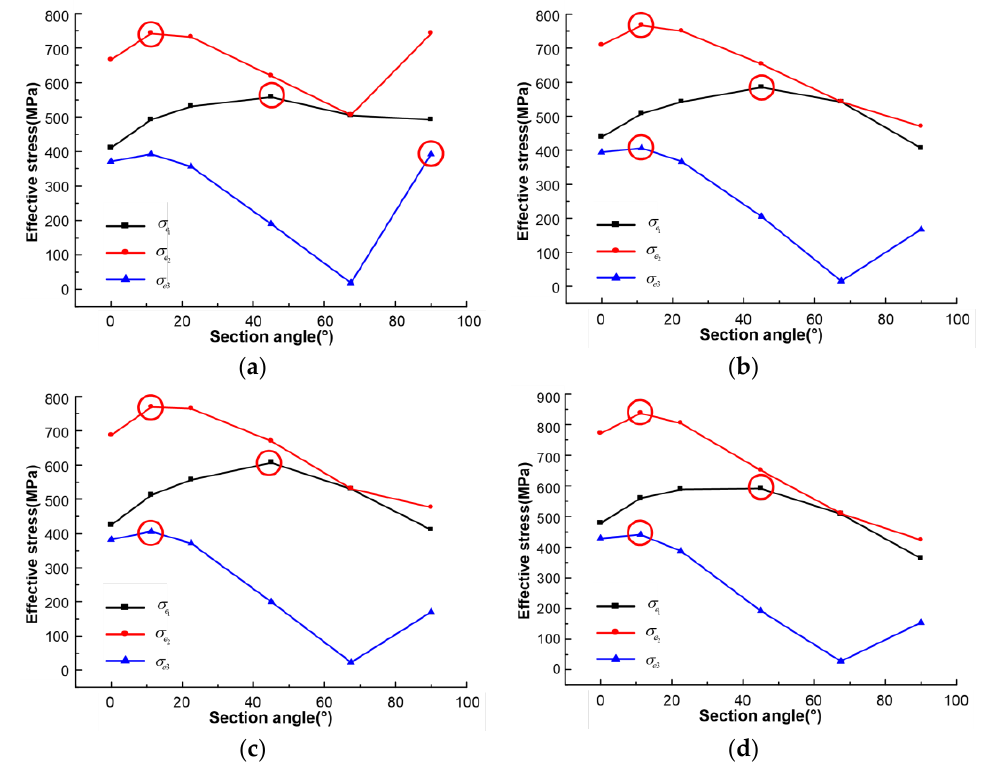
Figure 7. Typical effective stress of different weld sections in transverse fillet weld: ( a ) 1# weld; ( b ) 2# weld; ( c ) 3# weld; ( d ) 4# weld. (The red circle indicates the highest stress level of the curve).